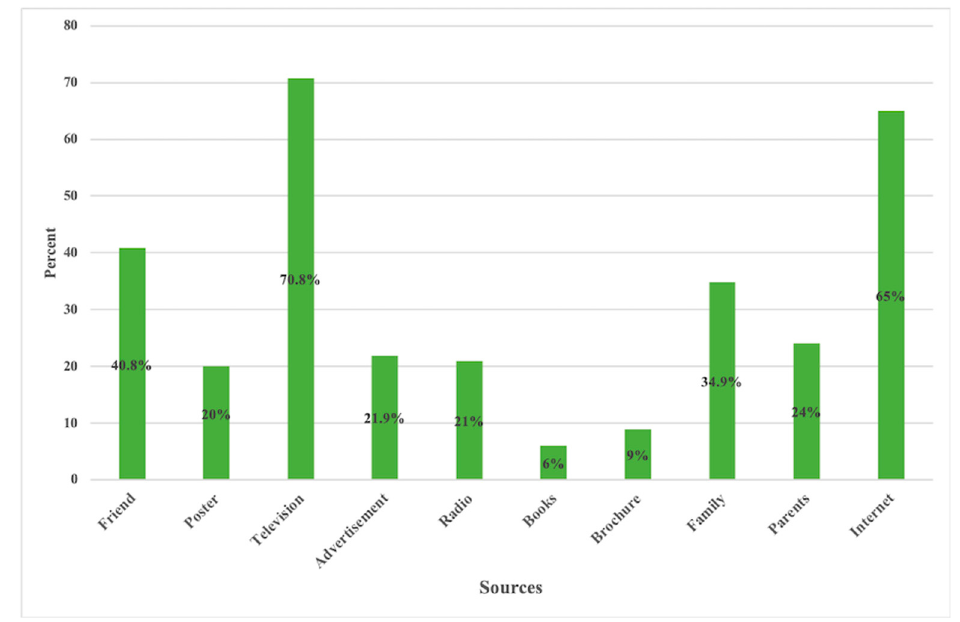
Figure 2. Different of sources of COVID-19 information among study participants in Phuentsholing Hospital, Bhutan.